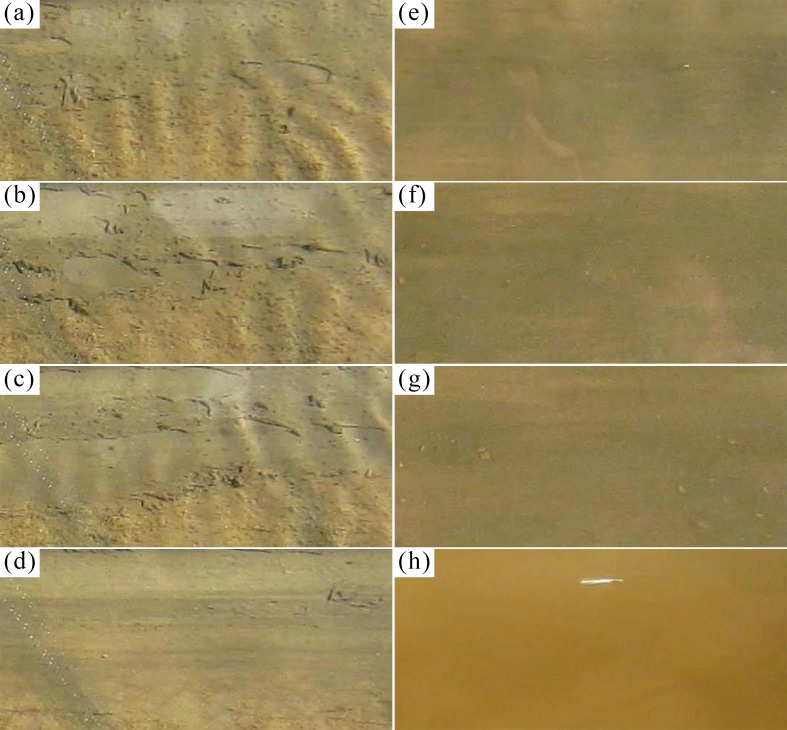
Sequential images displaying the erosion process of bio-sediment, i.e., from the destruction of the biofilm mat to the suspension of lower layers.The entire time interval (a-h) is nearly one hour. The images belong to three time groups: a-d, e-g and h. The time interval between adjacent images of each group is 20 s, and it is 30 min between different groups.